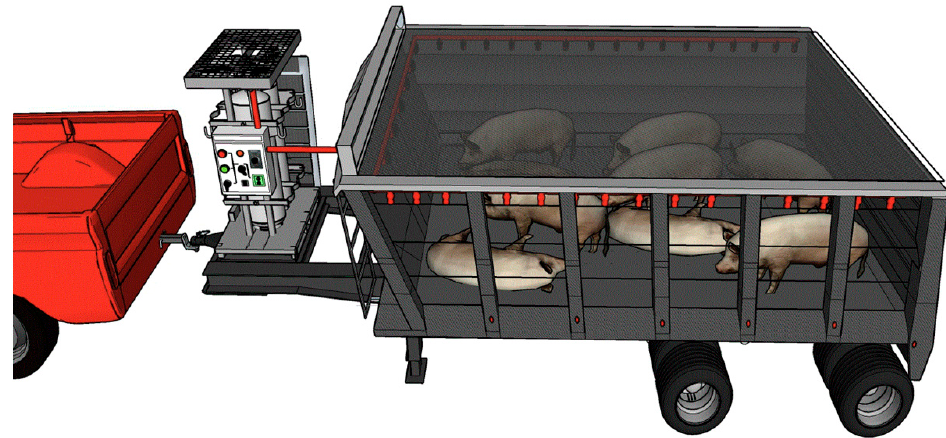
Figure 1. Schematic highlighting key components of the CO 2 vaporizer system. Add ‐ on components of heat treatment are presented in the later sections of the paper.